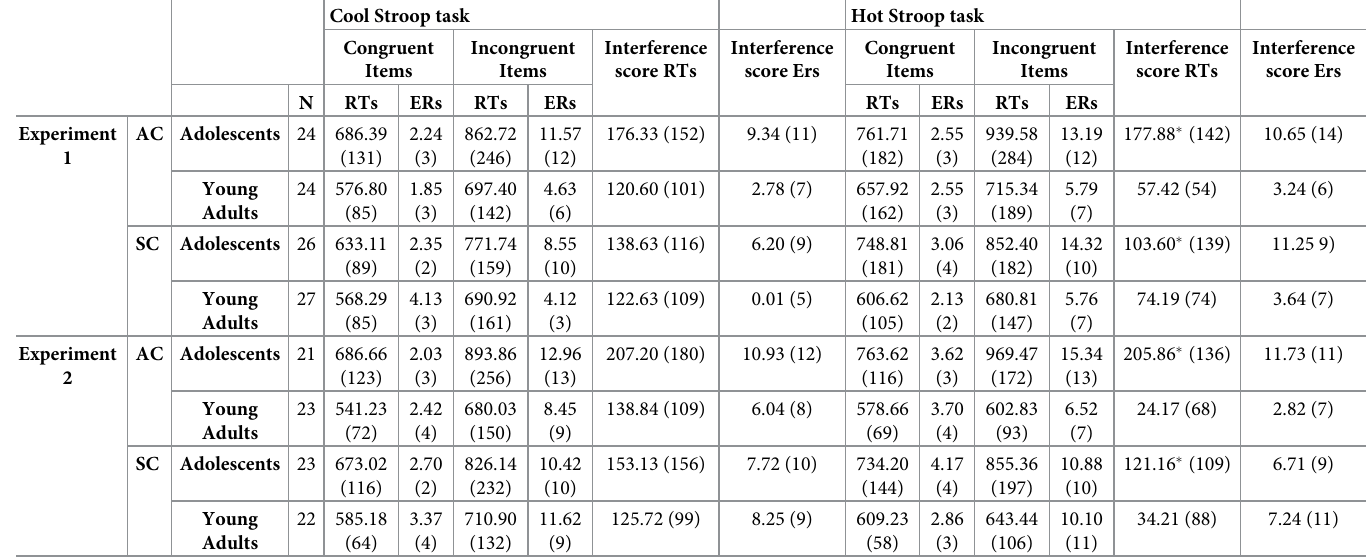
Table 2. Mean RTs (ms), mean ERs (%) for the Cool and Hot Stroop items for each age group and each social context condition (Alone condition: AC; Social evalua- tion condition: SE; standard deviations are in parentheses and � indicated significant d ifference between the AC and the SC conditions). Cool Stroop task Hot Stroop task Congruent